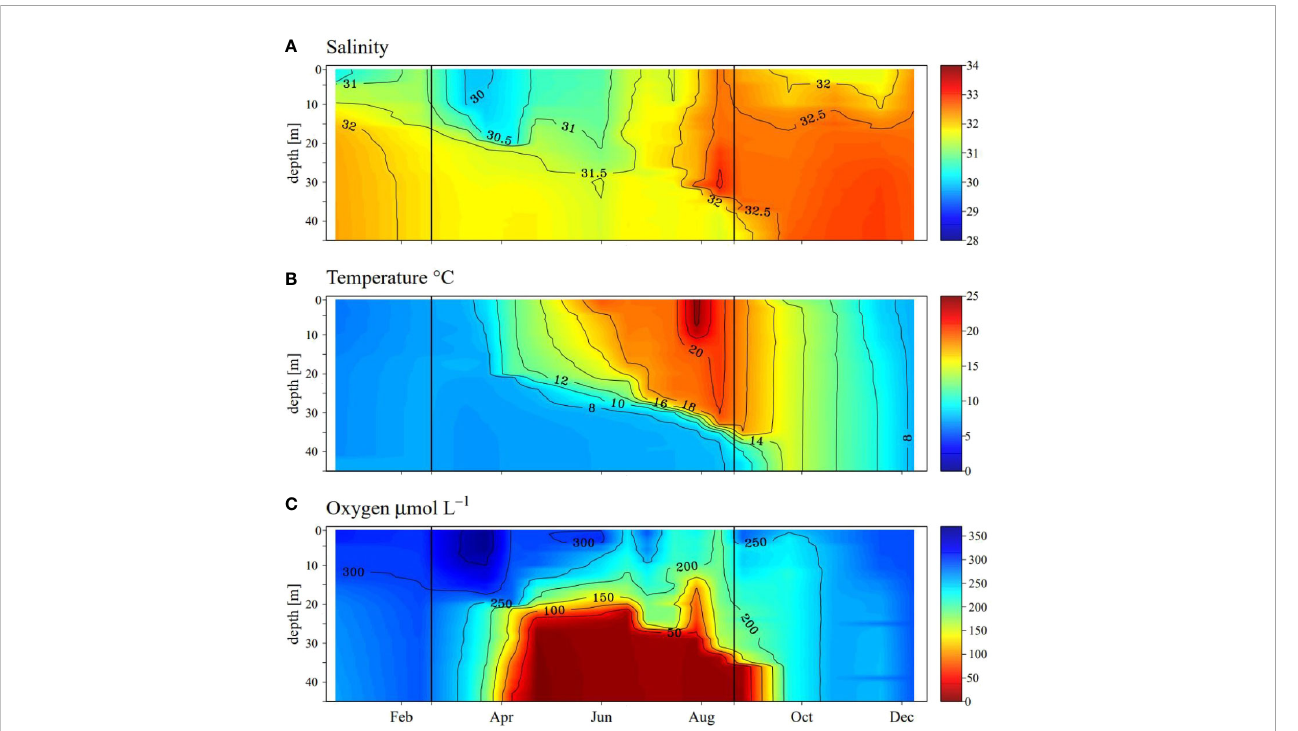
FIGURE 1 Seasonal dynamics of (A) : salinity, (B) : temperature and (C) : oxygen in the water column between January and December 2020 in the Scharendijke basin (Lake Grevelingen) in 2020. Data obtained from monitoring by Rijkswaterstaat (Directorate-General for Public Works and Water Management of the Netherlands. The observations were carried out every two weeks to one month, giving a total of 19 time points in 2020. Black vertical lines indicate the dates that the water column was sampled with RV Navicula (March and September